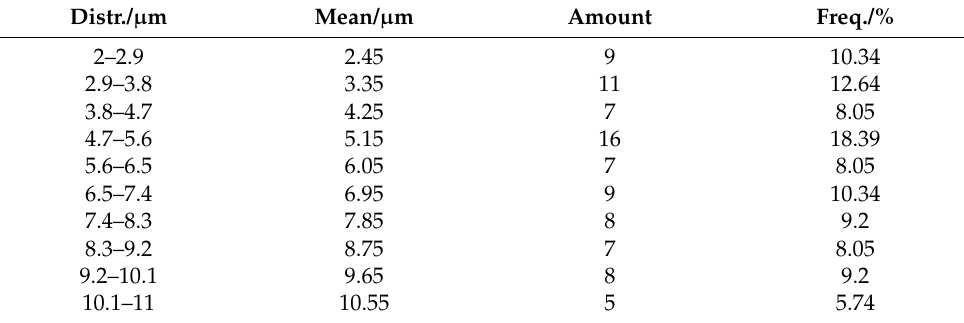
Table 2. Particle size distribution of fly